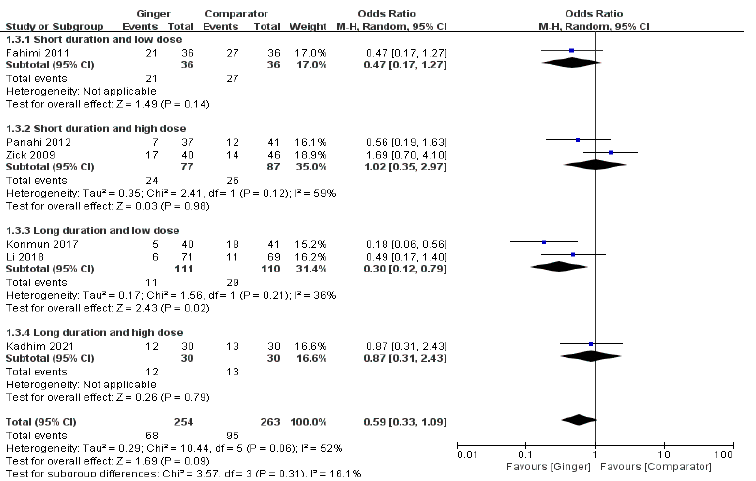
Figure 4. Effects of ginger intake on chemotherapy-induced acute vomiting. Short duration ≤ 4 days; Long duration > 4 days; Low dose ≤ 1 g/day; High dose > 1 g/day. Fahimi 2011 [19], Panahi 2012